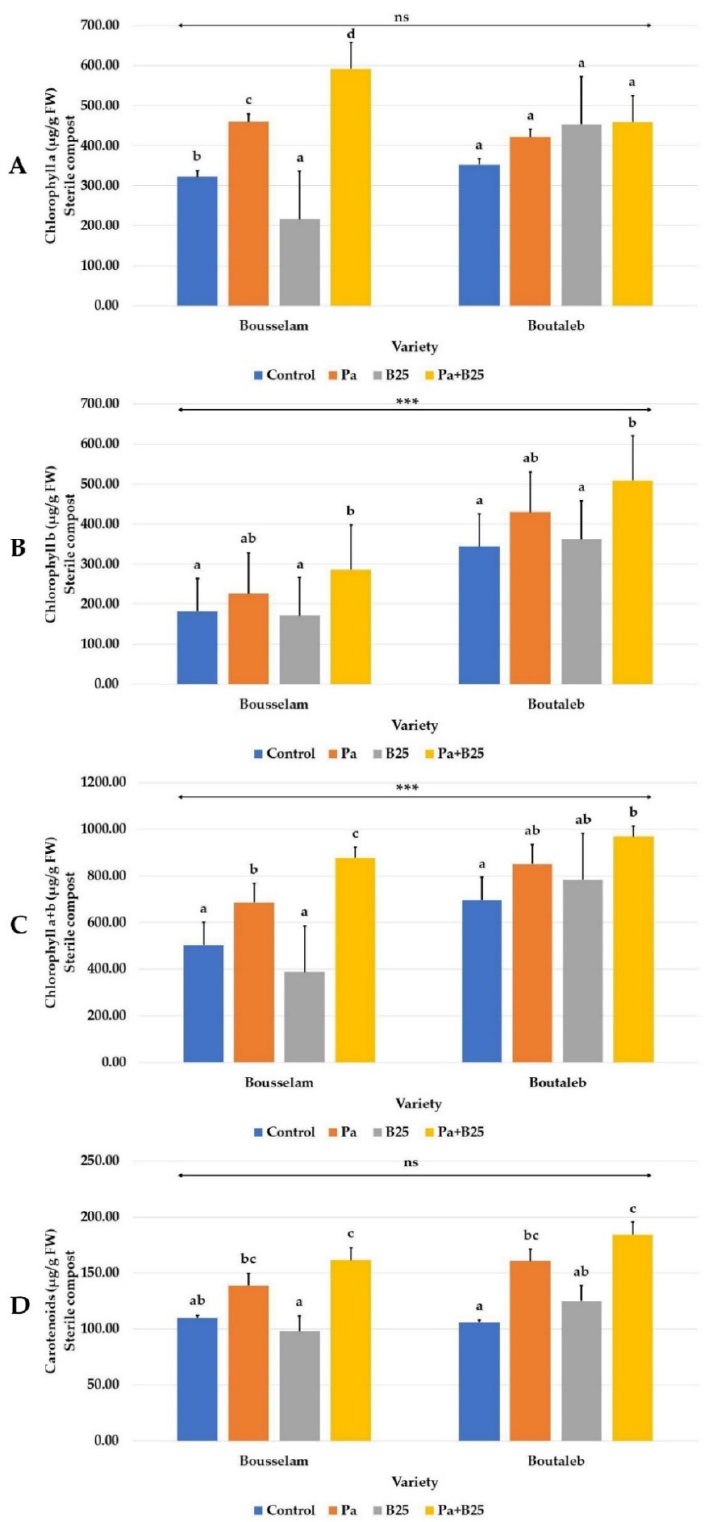
Figure 5. Effect of bacterial inoculation on ( A ) chlorophyll a (µg/g FW), ( B ) chlorophyll b (µg/g FW), ( C ) chlorophyll a + b (µg/g FW), and ( D ) carotenoid (µg/g FW) contents of wheat plants grown in sterile compost of Bousselam and Boutaleb varieties. The bar plots represent the mean ± standard error of three different experiments. IBM SPSS Statistics v.24 was used to perform statistical analysis, using a two-way ANOVA and Tukey’s multiple comparison post-test. Significant differences are displayed as: *** p < 0.001. ns: non-significant.